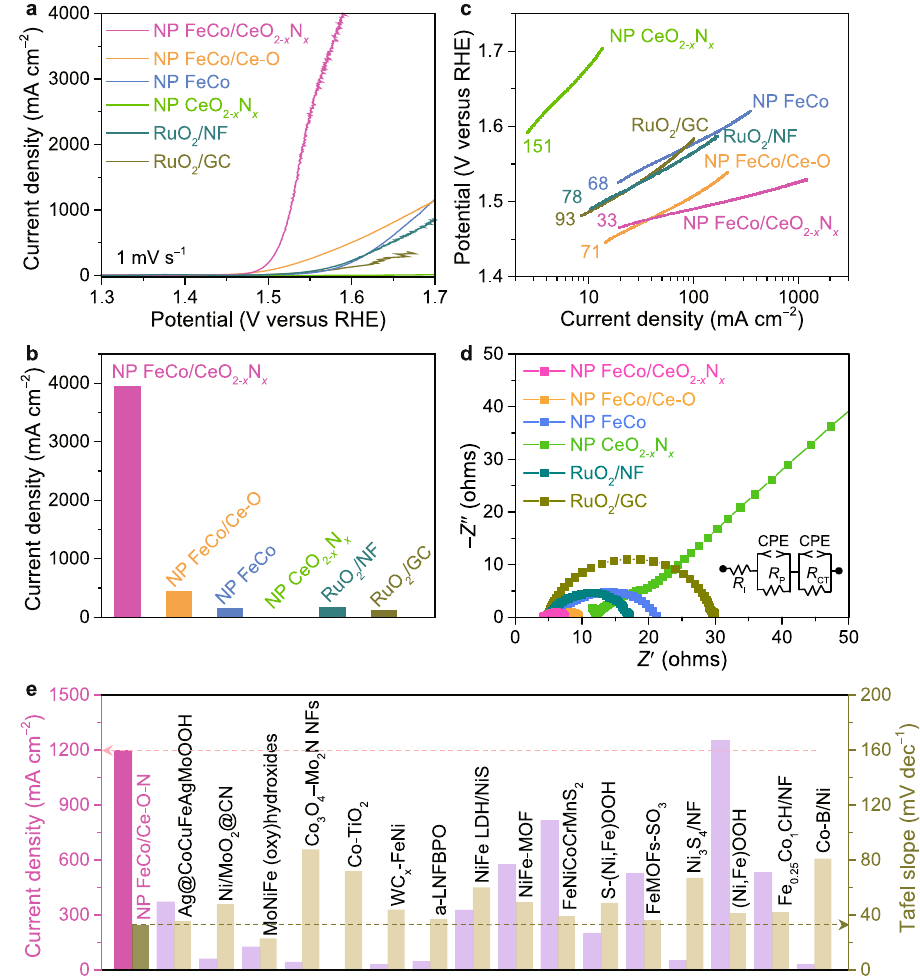
Fig.3|Electrochemicalpropertiesofnanoporouselectrodes.a OERpolarization curves for self-supported nanoporous (NP) FeCo/CeO 2 − x N x (pink), FeCo/Ce-O (yellow), FeCo (blue), CeO 2 − x N x (green) electrodes, RuO 2 electrodeposited on nickel foam (RuO 2 /NF, dark green) and commercially available RuO 2 nanocatalyst immobilized on glassy carbon electrode (RuO 2 /GC, dark yellow) in O 2 -purged 1M KOH electrolyte. Scan rate: 1mVs − 1 . b Comparison of current densities at the overpotential of 360mV for self-supported NP FeCo/CeO 2 − x N x , FeCo/Ce-O, FeCo, CeO 2 − x N x , RuO 2 /NF and RuO 2 /GC electrodes. c Tafel plots comparing the Tafel slopes of different catalysts according to the OER polarization curves in panel ( a